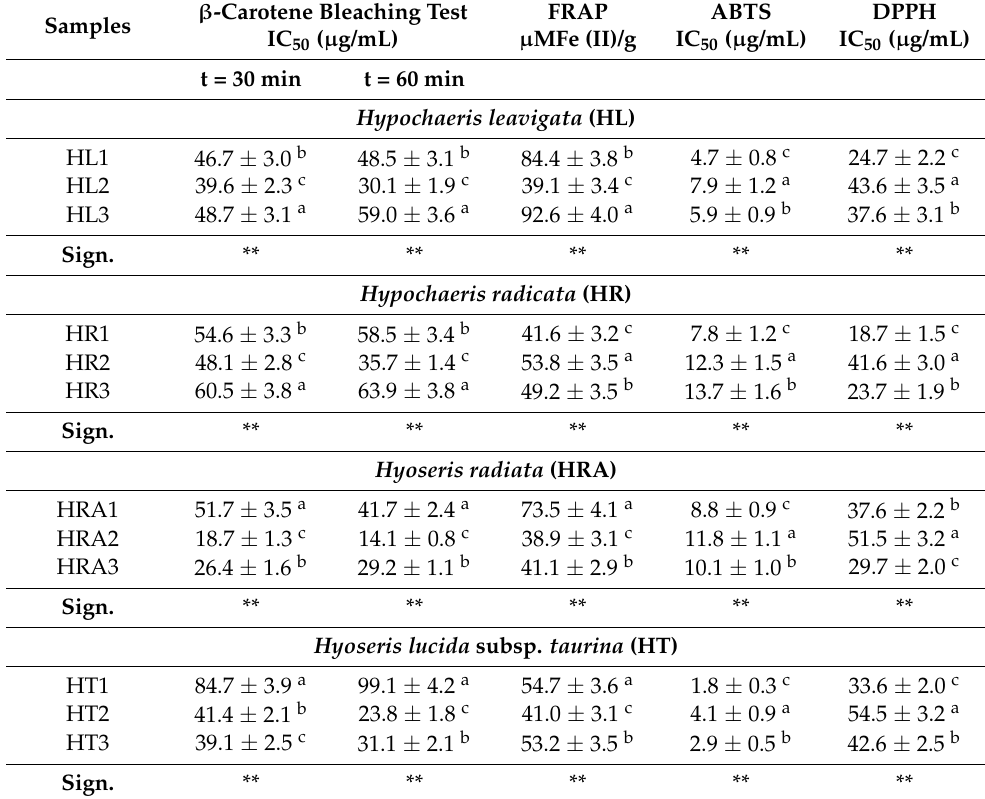
Table 4. Antioxidant activity of Hypochaeris and Hyoseris extracts.